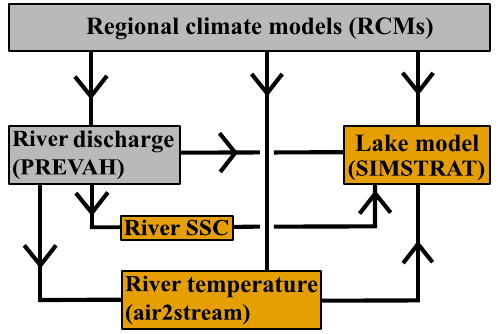
Figure 1. Schematic illustration of the one-way model chain of this study. Orange models represent modeling performed by this study, while grey models represent simulated data inputs obtained from external